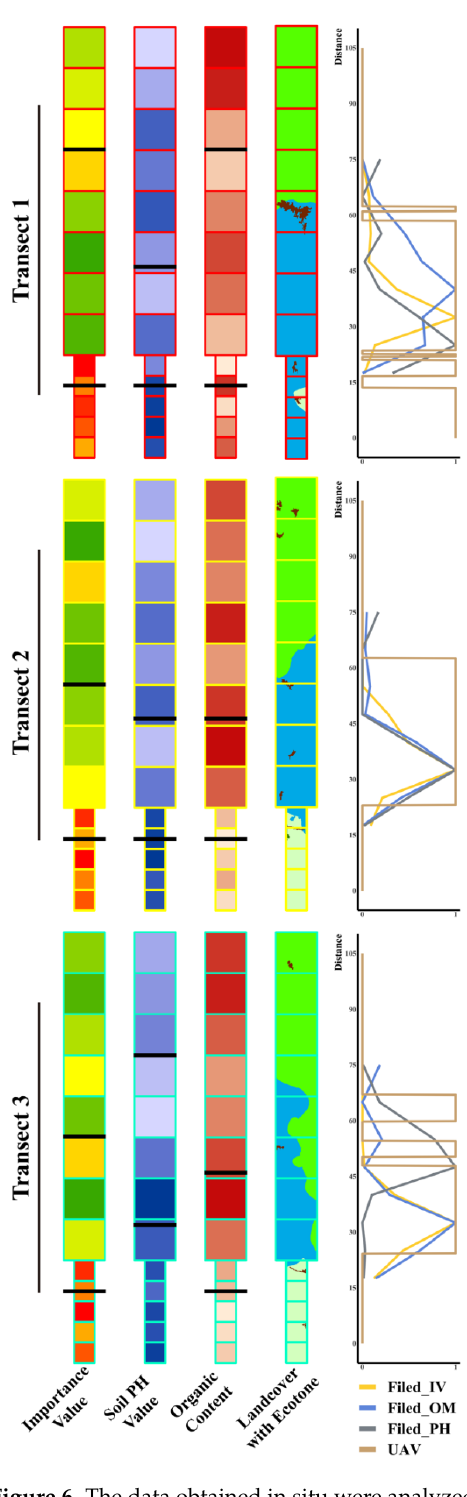
Figure 6. The data obtained in situ were analyzed based on transects. Every transect consists of 8 big quadrats (10 × 10 m) and five small quadrats (5 × 5 m). IV, pH, and OM were surveyed in every quadrat. In this figure, the first column (from left) denotes the distribution of IV along a transect, the second denotes pH, and the third is OM. Three color plates reflect the changes of value in each quadrat, and the higher the value of a quadrat, the deeper the color. The fourth column reflects a land cover with ecotones along a transect. The fifth column shows the changes of different indicators along the direction of the transect. The black lines in the first three columns act as scale to indicate the width of the ecotones detected based on the